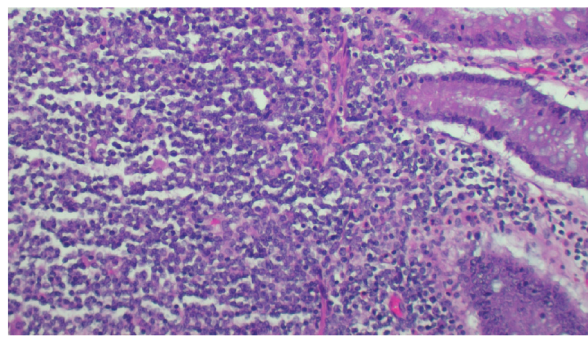
Figure 5: H&E stain showing normal colonic mucosa on the right and small lymphoma cells on left. Cyclin D1+, CD5+ (weak), K67 ∼ 68%.